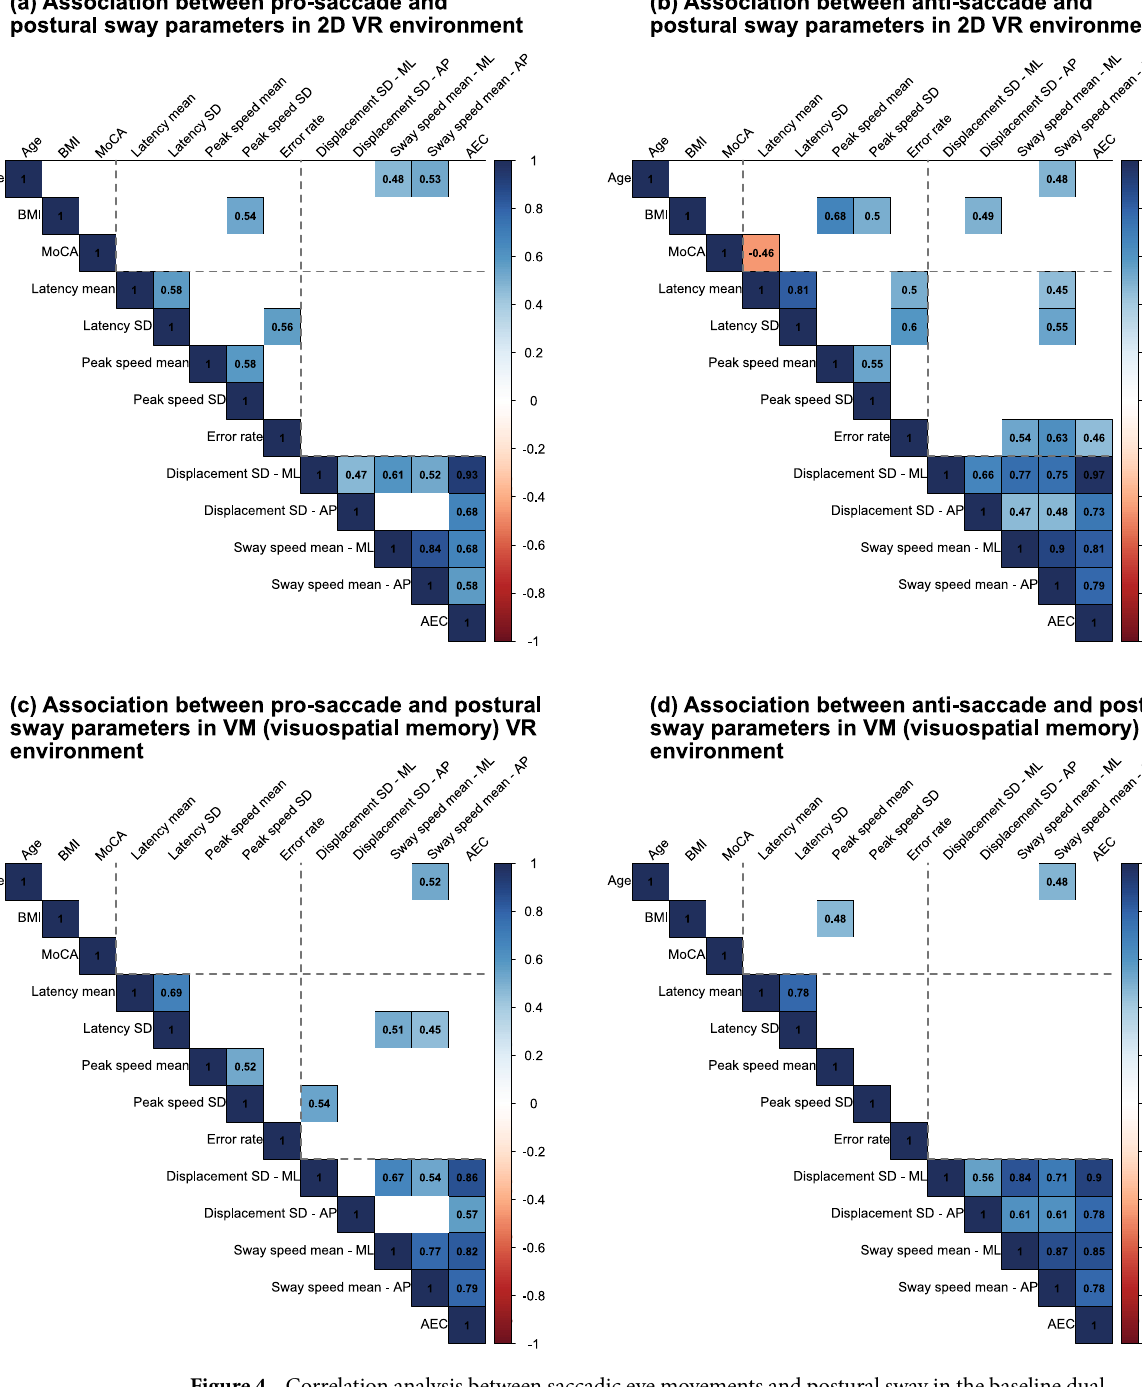
2D and VM VR environments). Associations in 3D and SO VR environments are also found in Supplementary Fig. S2 online. Only the associations at 5% significance level were highlighted.